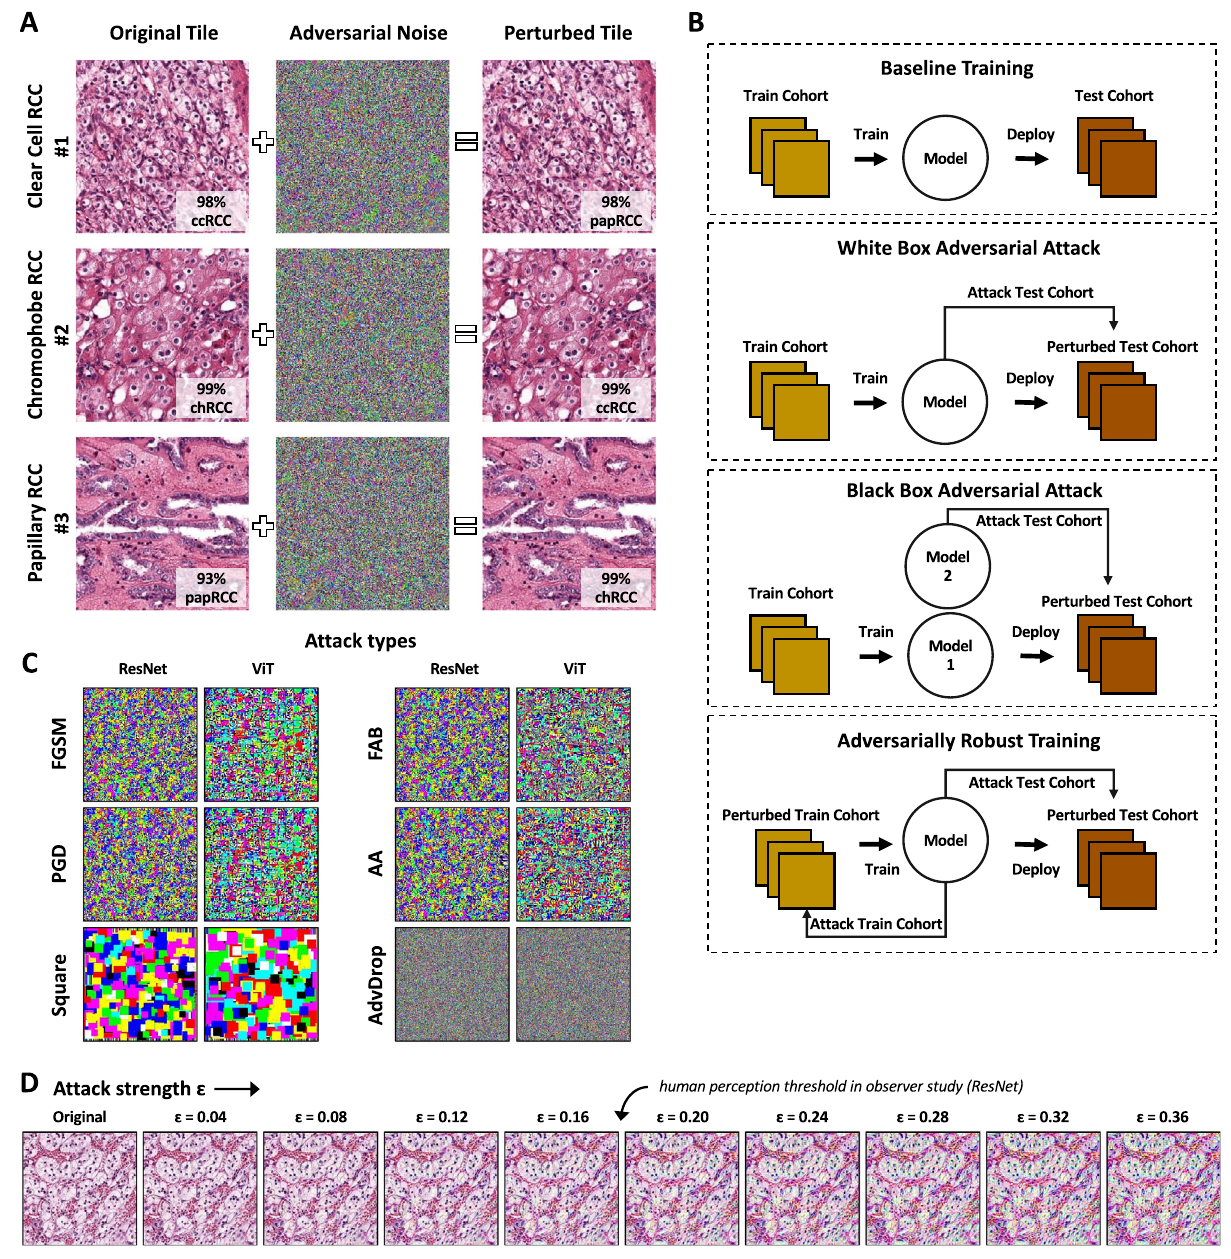
Fig. 2 | Adversarial attacks on computational pathology. A Adversarial attacks add noise to the image and fl ip the classi fi cation of renal cell carcinoma (RCC) subtypingintoaclearcell(cc),chromophobe(ch),andpapillary(pap).Themodel ’ s prediction con fi dence is shown on each image. B Experimental design for the baseline (normal) training, white-box, and black-box attacks and for adversarially